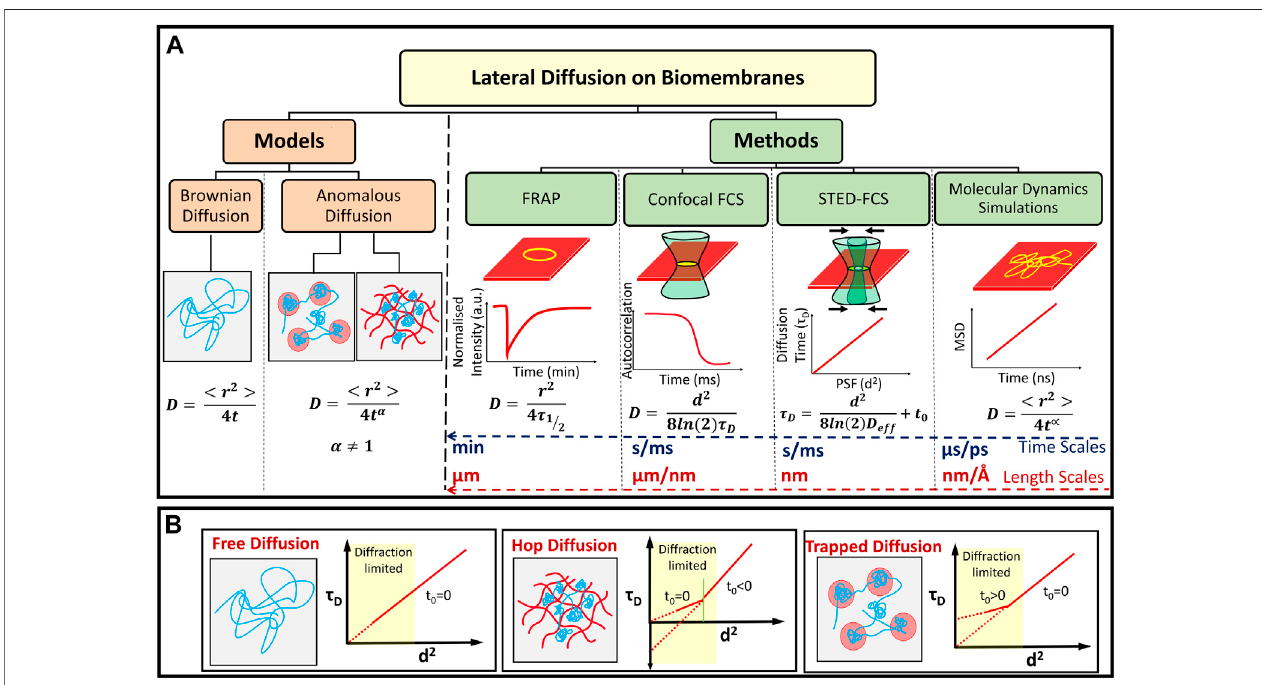
FIGURE 4 | (A) Models of lipid diffusion in biomembranes and methods used to study molecular diffusion at different length and time scales. Diffusion can be classi fi ed as anomalous or Brownian depending on the value of the parameter α . The typical temporal and spatial resolution for probing membrane lipid diffusion using various experimental techniques as well as MD simulations are indicated. (B) Schematic representation of different τ D vs d 2 curves attributed to free, hop and trapped diffusion mechanisms observed on lipid cell membranes (Lenne et al., 2006; Winkler et al.,